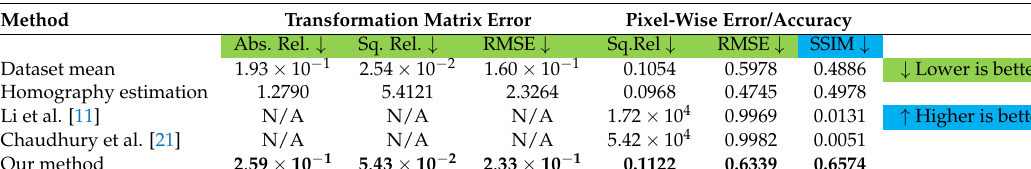
Table 5. Accuracy metrics of the network’s scaling prediction using images with scaling distortion. Our network recovers the scale of images properly. Best performance in bold.